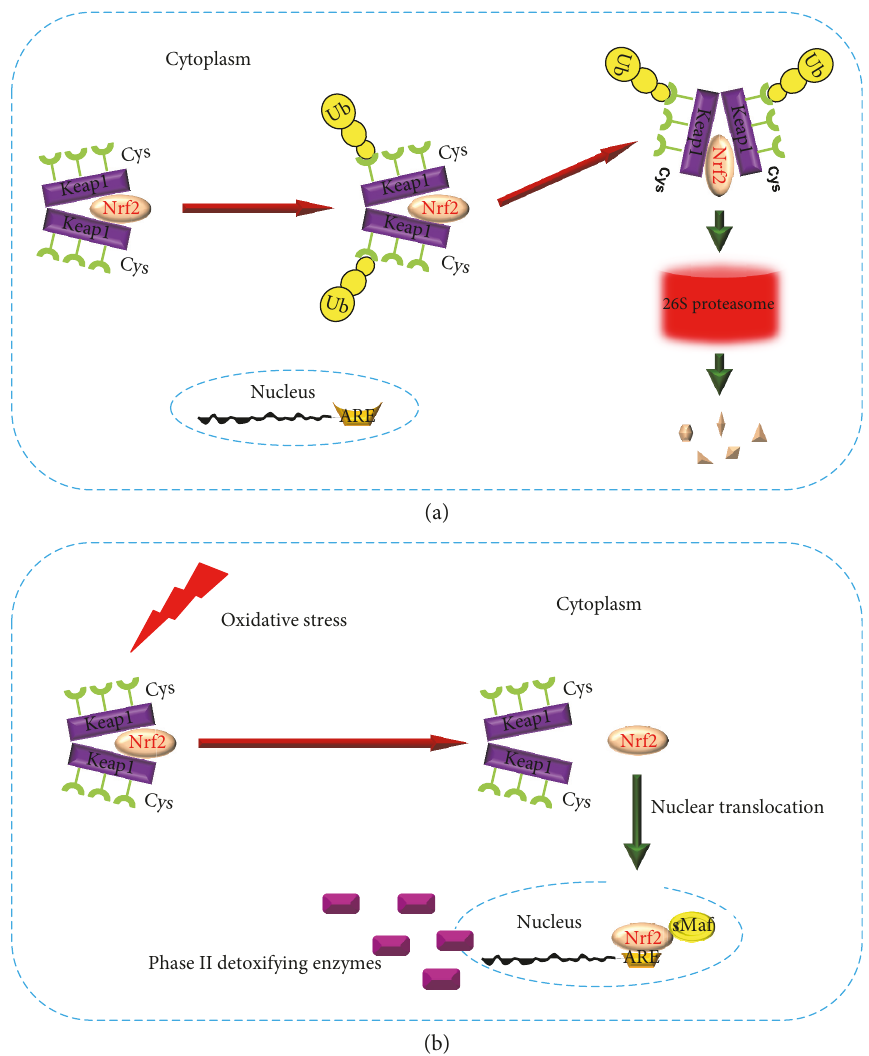
Figure 2: Working model of Nrf2/ARE pathway. (a) Working model of Nrf2/ARE pathway under rest conditions. (b) Working model of Nrf2/ARE pathway during oxidative